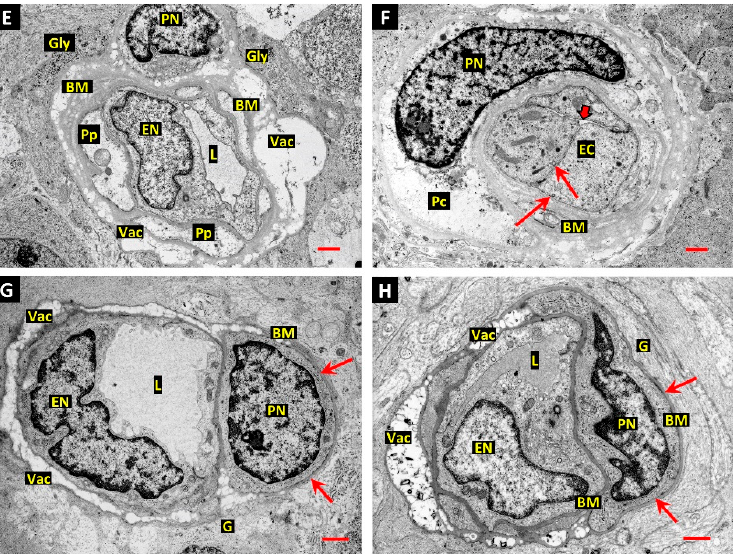
Figure 1. Assessment of post-mortem change in human retinal capillaries. ( A , B ): Retinal capillary profiles from diabetic donor eye retina show intact endothelial cells (EC) with a normal distribution of well-preserved mitochondria, endoplasmic reticulum, and free polyribosomes. In contrast, the adjacent pericyte processes (Pp) are pale and swollen with sparse, swollen mitochondria and endoplasmic reticulum. However, the plasma membranes appear intact and still show dense matrix-attachment sites. The glial processes forming the glia limitans are well-preserved and show darkly stained aggregates of glycogen particles (Gly) and dense bundles of intermediate filaments (IF) interspersed with microtubules. The distinctive basal polarization of the plasma-membrane caveolae was preserved and caveolae fully occupied large stretches of the basal plasma membrane of the endothelial cells (arrow heads in panel B). Age-related basement membrane (BM) vacuolation (Vac). Panel A, bar 1.0 µ m; panel B, bar 1.0 µ m. ( C ): Electron micrograph of small retinal vessel from diabetic donor. The vessel is larger than a capillary but because the mural cell covering has been lost, it is unclear whether it was a small arteriole or venule. The basement membrane is thickened and laminated, and the endothelial cell shows numerous luminal microvilli (arrows). The glial cells forming the glia limitans contain dense masses of glycogen particles. Age-related BM vacuolation (Vac). Bar 1.0 µ m. ( D ): Retinal capillary from diabetic donor retina shows complete pericyte loss and the basement membrane is grossly thickened and laminated. The endothelial cell appears viable and numerous luminal microvilli are present, suggestive of early post-mortem (PM) migratory activity. Bar 1.0 µ m. ( E ): Retinal capillary from diabetic donor shows an intact endothelial cell and pericyte with swollen cell processes and increased granularity of the chromatin in the cell nucleus (PN) compared to that of the endothelial nucleus (EN). The perinuclear cytoplasm of the pericyte retains some mitochondria and cytoplasmic polysomes. Glycogen deposits are present in the processes of the glia limitans (Gly). Bar 1.0 µ m. ( F ): Retinal capillary showing a swollen pericyte with more advanced PM necrosis than that depicted in panel E. The nuclear chromatin is more granular, and the nuclear envelope is disintegrating. Much of the content of the perinuclear cytoplasm (Pc) has been completely lost and only small remnants of the plasma membrane can be detected. The extreme swelling of the pericyte has closed the vascular lumen (thick arrow), although the endothelia cell cytoplasm and organelles appear intact. Clathrin-coated pits are present at both the luminal and basal plasma membranes (arrows). Bar 1.0 µ m. ( G , H ): Retinal capillaries from promptly fixed retinas of 58-year-old (panel G) and 55-year-old (panel H) normal human surgical specimens. Both vessels show the same “Swiss cheese” BM vacuolation that is typical of adult human retinal capillaries (Vac). However, in contrast to the thickened and laminated BMs in retinal capillaries of diabetic donors, the segments of BM unaffected by vacuolation at the glial interface (arrows), and at the pericyte–endothelial interfaces, are relatively thin and regular. Furthermore, the nuclear chromatin, cytoplasmic electron density, and cytoplasmic organelles are similar in pericytes and ECs. Endothelial nucleus (EN); pericyte nucleus (PN); vessel lumen (L); glial processes (G). Bars 1.0 µ